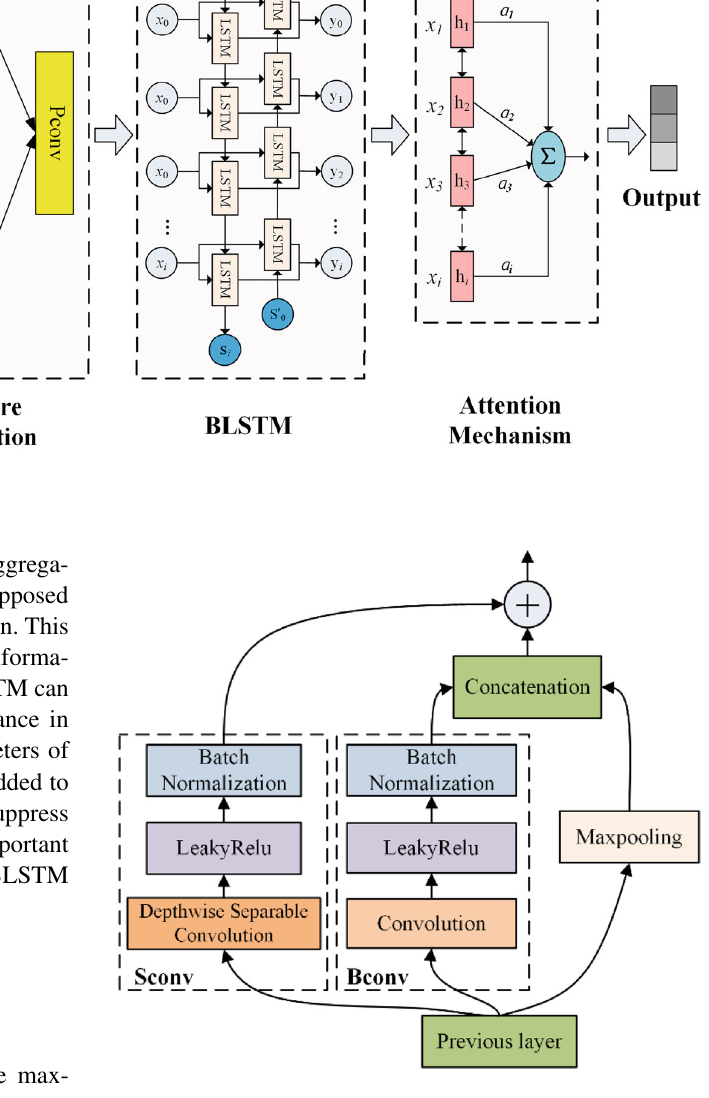
Fig. 2 The structure diagram of Pconv